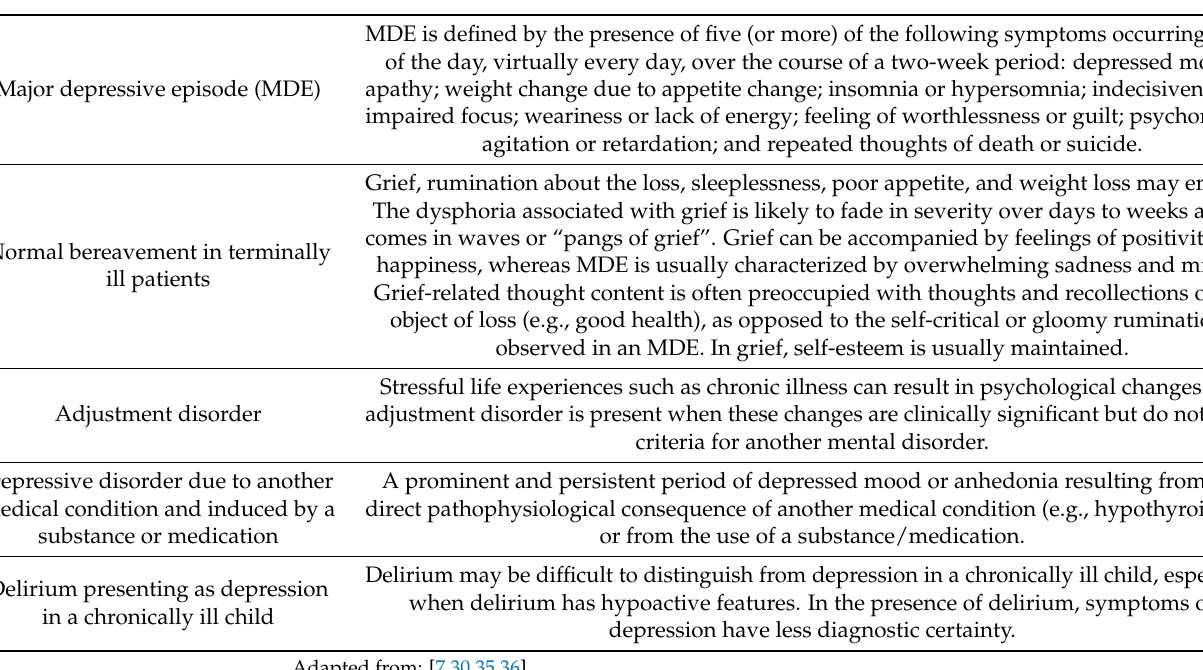
Table 3. Differential diagnosis of depressive illness in physically ill